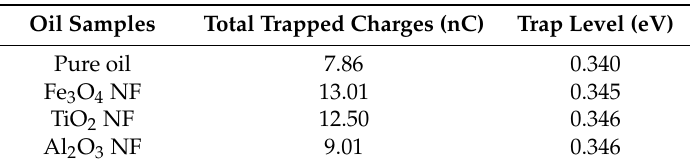
Figure 8. Thermally stimulated currents of pure oil and nanofluids. Table 1. Trap characteristics of pure oil and